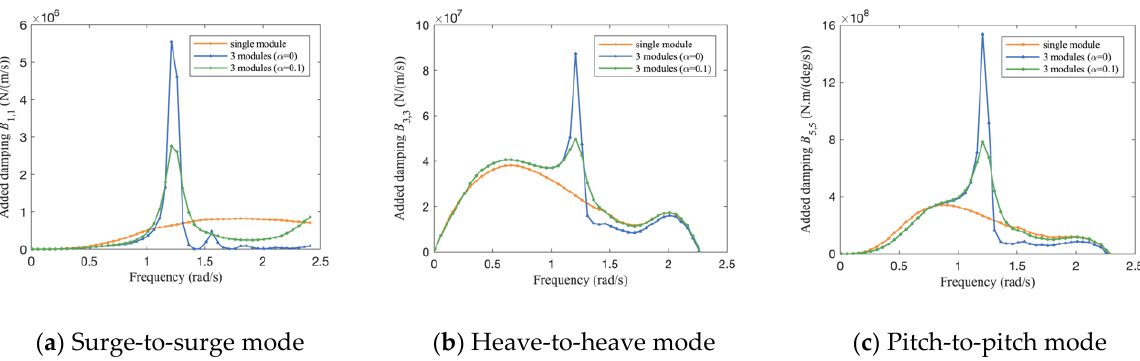
Figure 6. Comparison of the added damping coefficients.